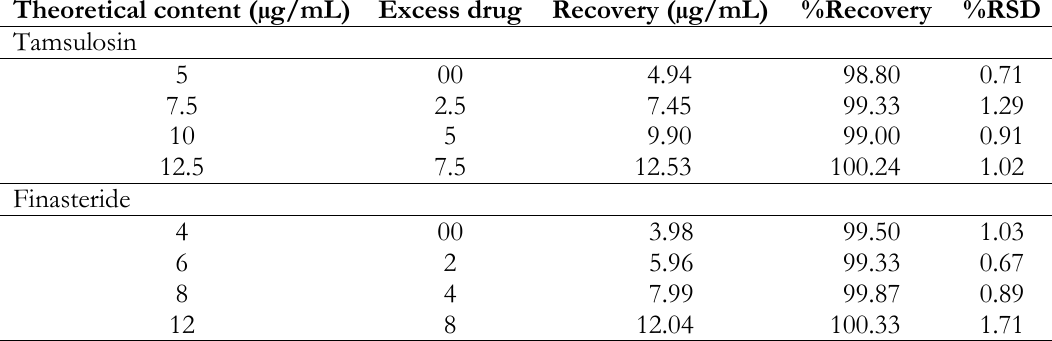
Table III. Recovery Table Theoretical content (µg/mL)